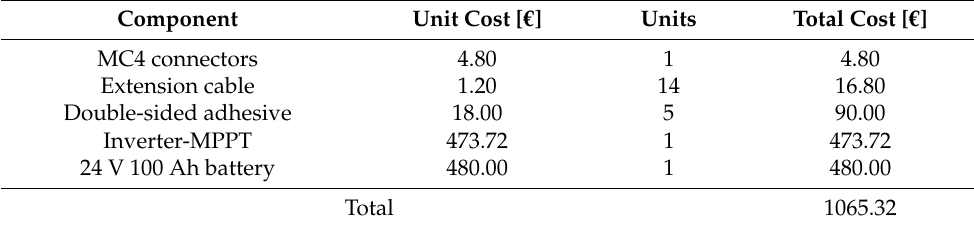
Table 3. Common costs for PV system